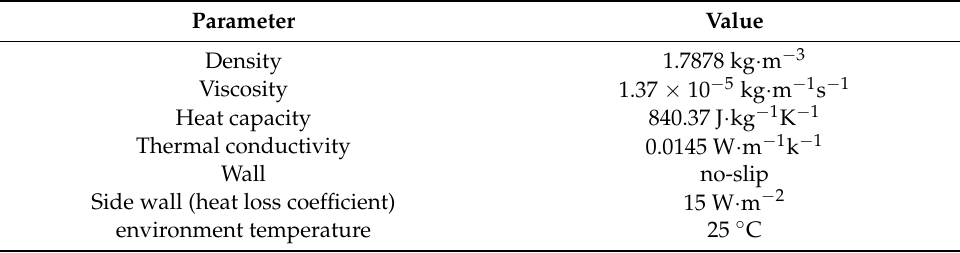
Table 3. Input parameters and boundary conditions used for CFD simulations.